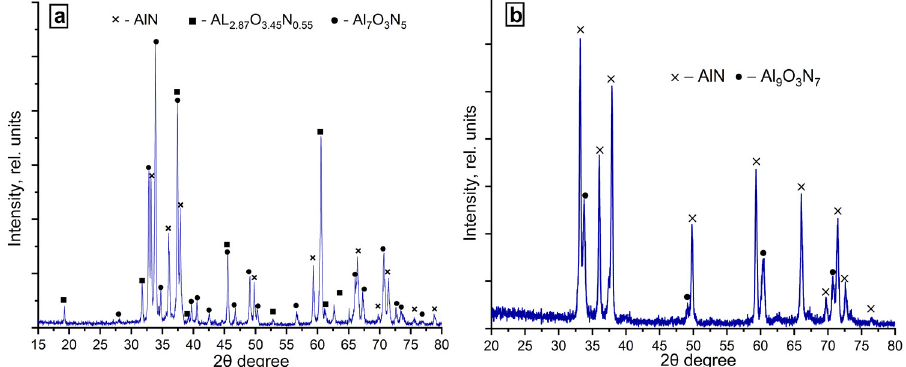
Figure 9. XRD patterns of the combustion products obtained from the (70% AlN+ 30% Al) sample in the nitrogen flow: ( a ) q = 1.5 cm 3 /(s∙cm 2 ) and ( b ) q = 5.0 cm 3 /(s∙cm 2 ).